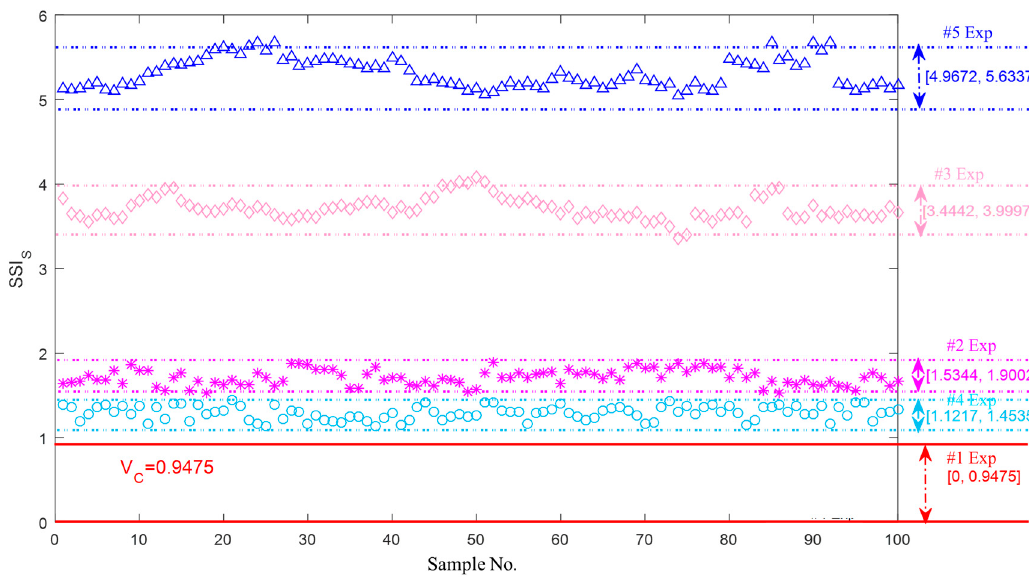
Figure 14. Upper and lower boundaries of SSI S for quantification of the bearing vibration signals with the different faults.